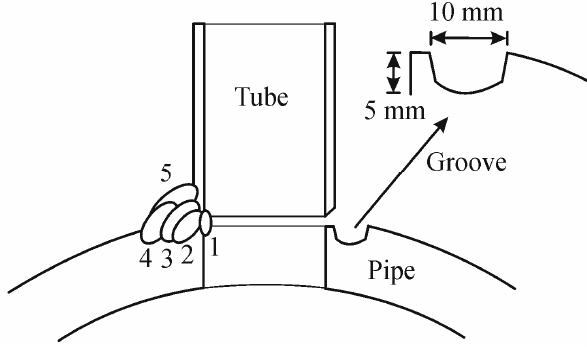
Figure 1. Schematic of grooved fillet joint of Fe-2.25Cr-1Mo tube and carbon steel pipe.